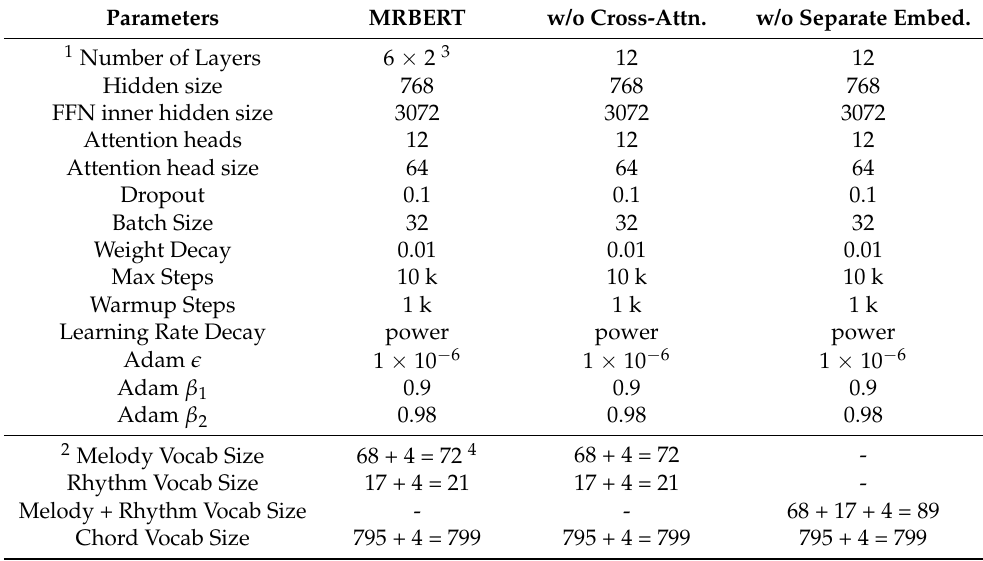
Table 1. Hyperparameters for pre-training and fine-tuning of MRBERT (with ablation model). Parameters